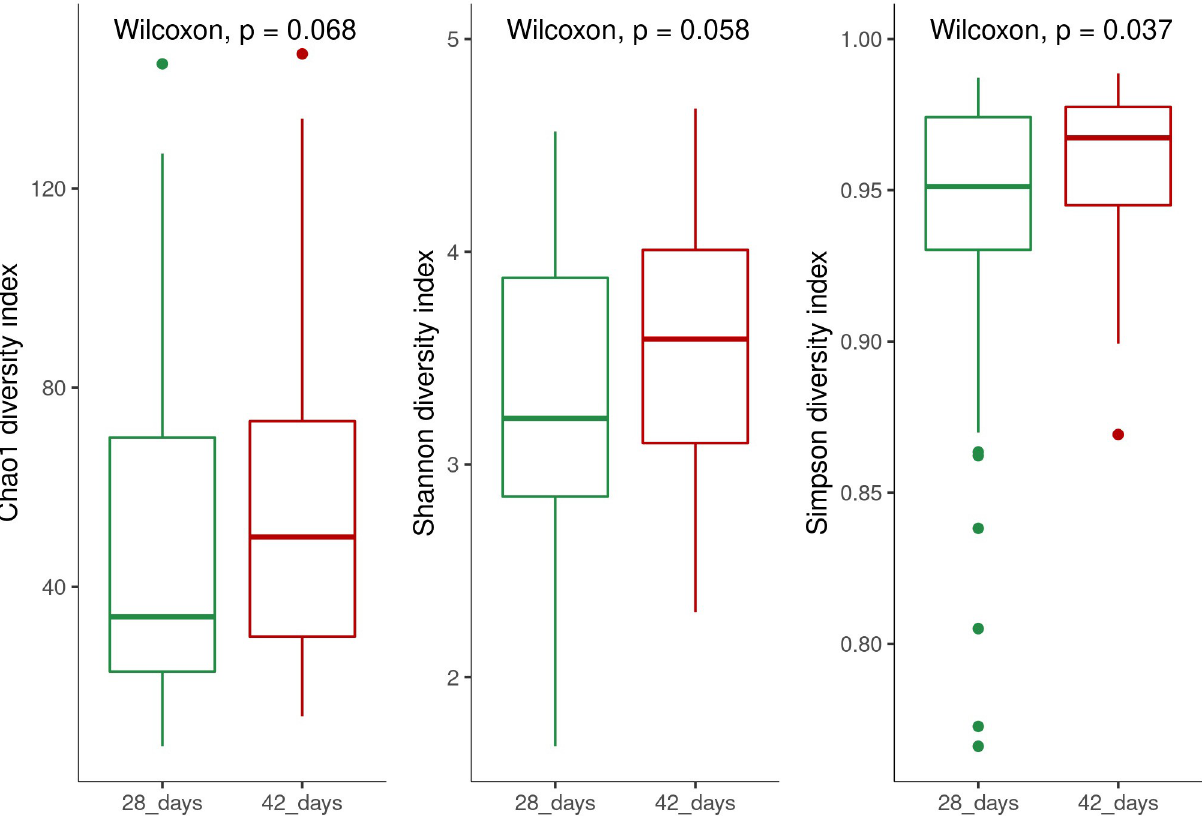
Fig 1. Alpha diversity of broilers cecum samples at 28 and 42 d of trial. The study tested seven feed additives: enramycin (8 ppm), virginiamycin (16.5 ppm), tylosin (55 ppm), CNSL–castor oil (CNSL-CO) at different doses (0.5, 0.75, and 1.00 kg/t), and the control diet (without additives). Comparison over time (28 and 42 d) using Chao-1, Shannon, and Simpson